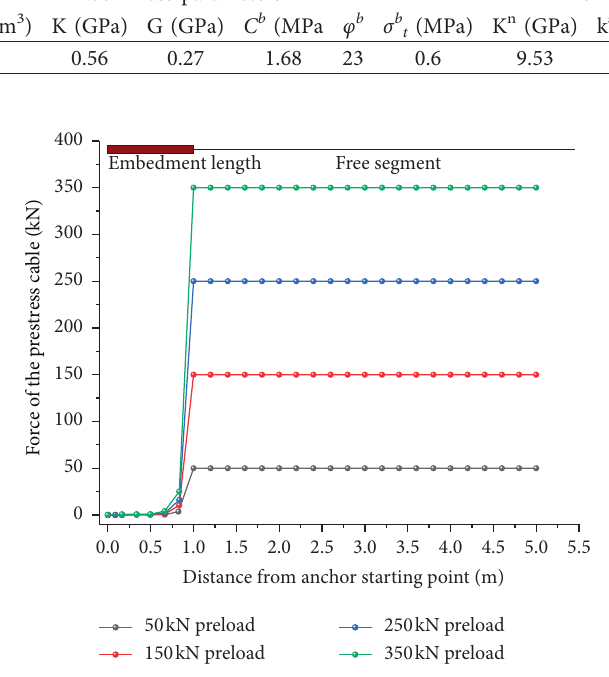
Figure 22: The stress distribution curve of the prestressed cable.